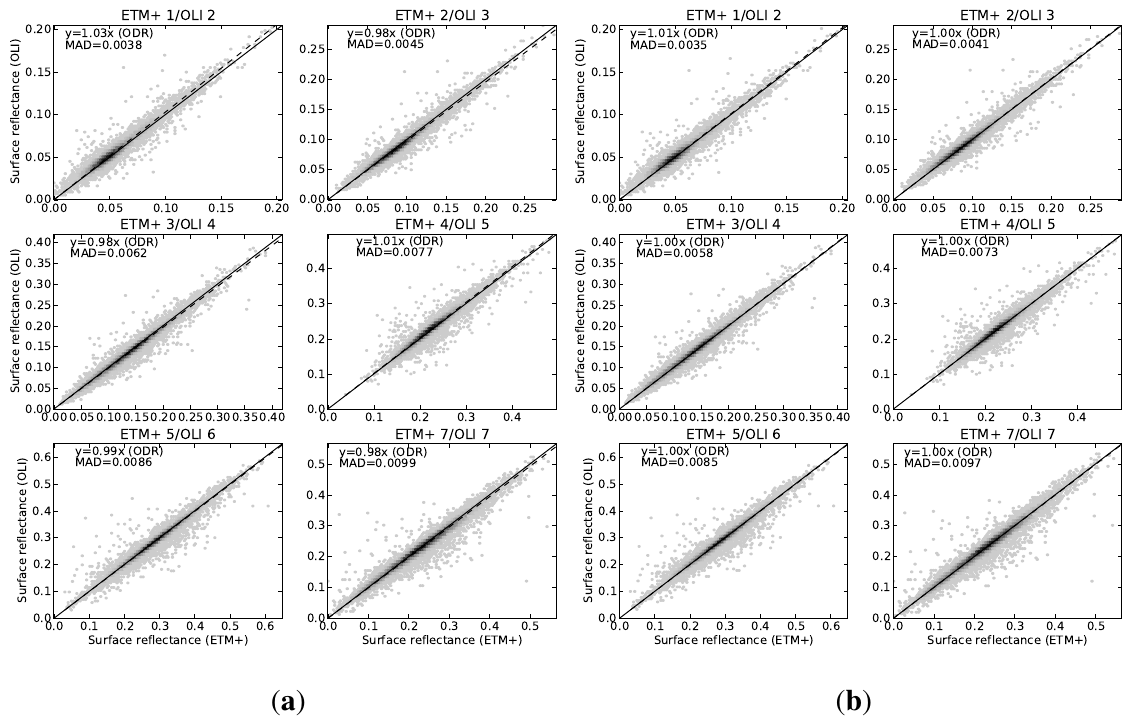
Figure 5. Surface reflectance for Landsat-7 and Landsat-8. ( a ) Reflectance for corresponding bands, without adjustment; ( b ) Reflectance for corresponding bands, with OLI values adjusted using fitted regression to match ETM+ values. Solid line is the one-to-one line, dashed line is the ODR